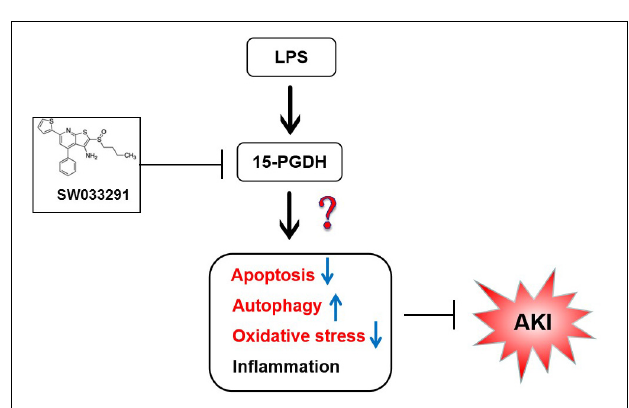
FIGURE 9 | The summary flow